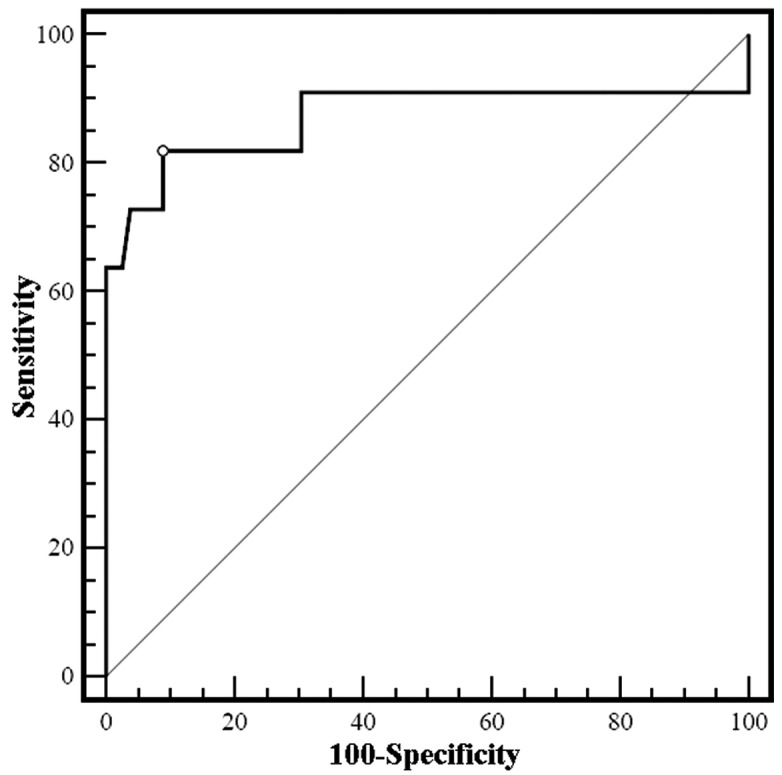
ROC curve of percentage of N-acetyl-β-D-glucosaminidase (NAG) increase for acute kidney injury (AKI) prediction. The area under the curve was 0.878 (95% CI, 0.699–1.043, P<0.01) for a NAG increase of 235.44%, with diagnostic sensitivity and specificity of 81.8 and 91.1%, respectively.